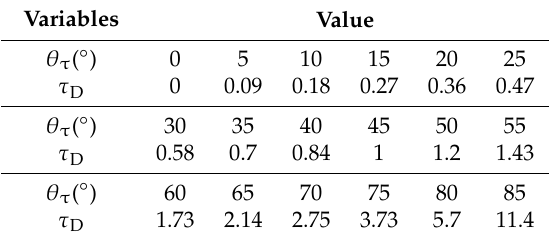
Table 2. Discrete error angle switching table.